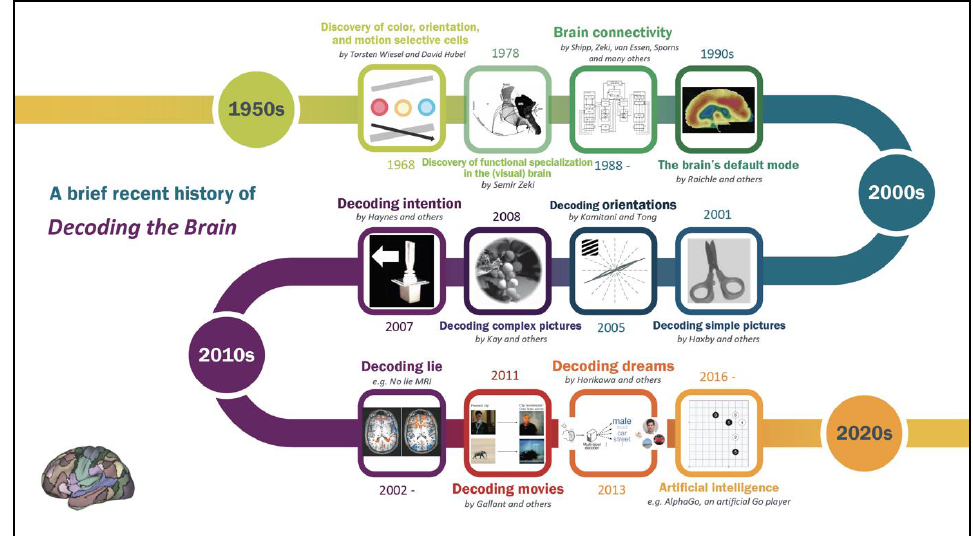
Figure 6. A timeline representing a few important discoveries in brain decoding during the past half-century